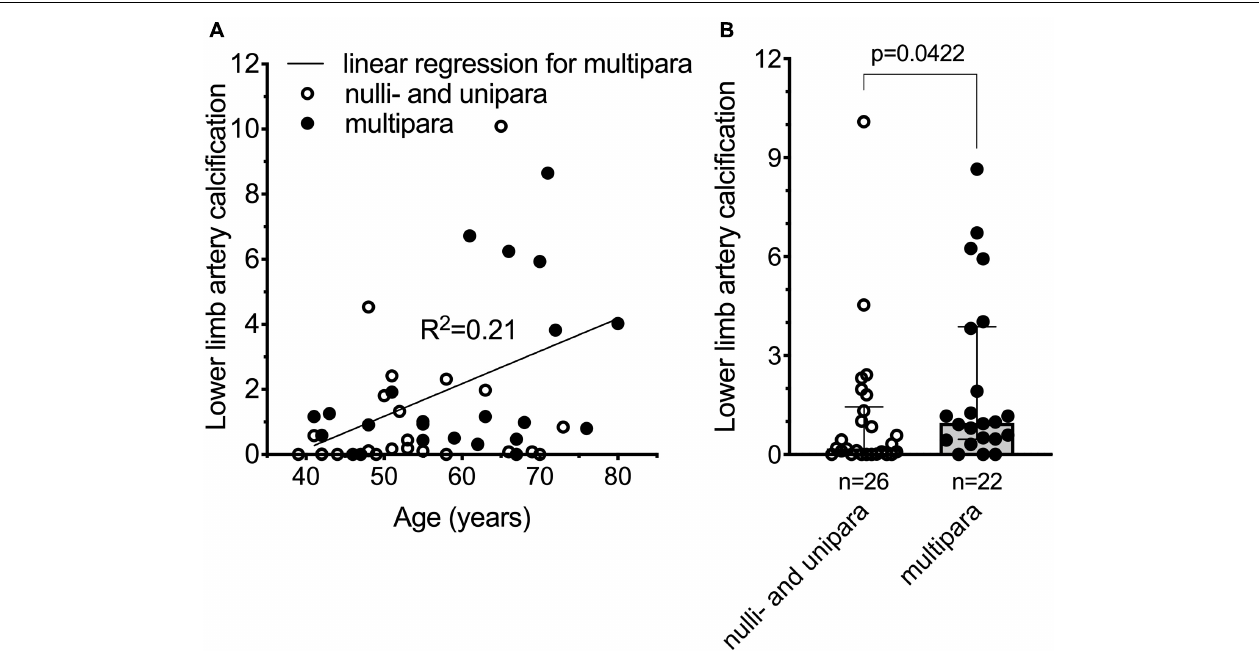
FIGURE 3 | Cardiovascular disease risk is increased in pseudoxanthoma elasticum patients giving multiple ( > 2) childbirths. (A) Normalized lower limb artery calcification (nLLAC) score versus age in nulli/unipara ( n = 26, open circles) and in multipara ( n = 22, closed circles) with the result of a simple linear regression performed for nLLAC score versus age in multipara. (B) nLLAC score is higher in multiparous PXE patients ( n = 22, closed circles, gray bar) compared to nulli/uniparous PXE patients ( n = 26, open circles, white bar). The 48 year-old nulliparous subject with renal amyloidosis had an LLAC and nLLAC of 6,955.4 and 4.54, respectively. Data were analyzed using GraphPad Prism 8.3.0. According to Kolmogorov-Smirnov test data for panel (B) did not follow normal distribution. We used unpaired non-parametric two-tailed Mann-Whitney test to analyze significance. Bars represent medians with 25th–75th interquartiles. Significance was accepted at p <